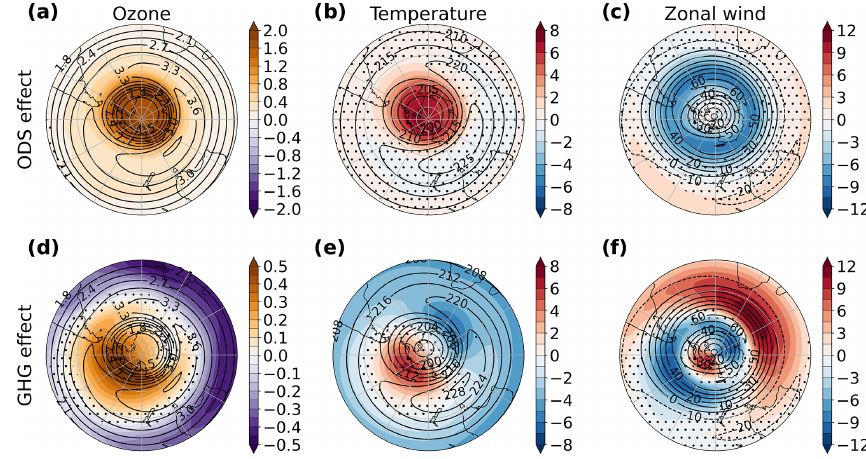
Figure 5. Changes in ozone ( a , d ; ppmv) and temperature ( b , e ; K) at 50hPa and in zonal wind ( c , f ; ms − 1 ) at 20hPa during October due to ODSs (a–c) and GHGs (d–f) . The contours depict the current-day (2011–2030) climatology from INTERACT_O 3 . The stippling masks regions where the changes are not significant at the 95% confidence interval based on a two-tailed t